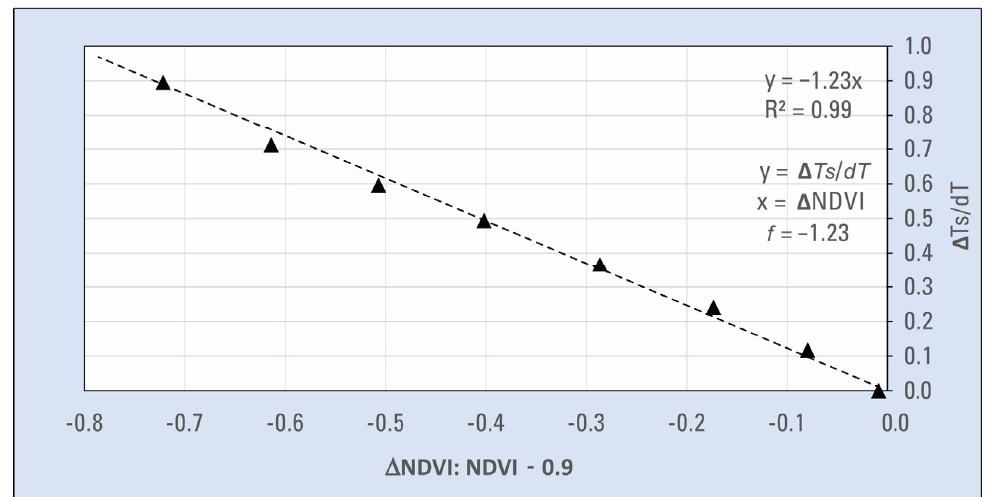
Figure 4. An illustrative Senay Approximation showing the inverse linear relation between a normal- ized surface temperature difference and NDVI difference ( ∆ Ts * /dT * versus ∆ NDVI * ). To reduce chart clutter, the * is omitted in the labels; all parameters represent large-area averages determined by the pixel counts in Table 1. Only positive NDVI values over land/vegetated surfaces are valid for the proposed approximation.